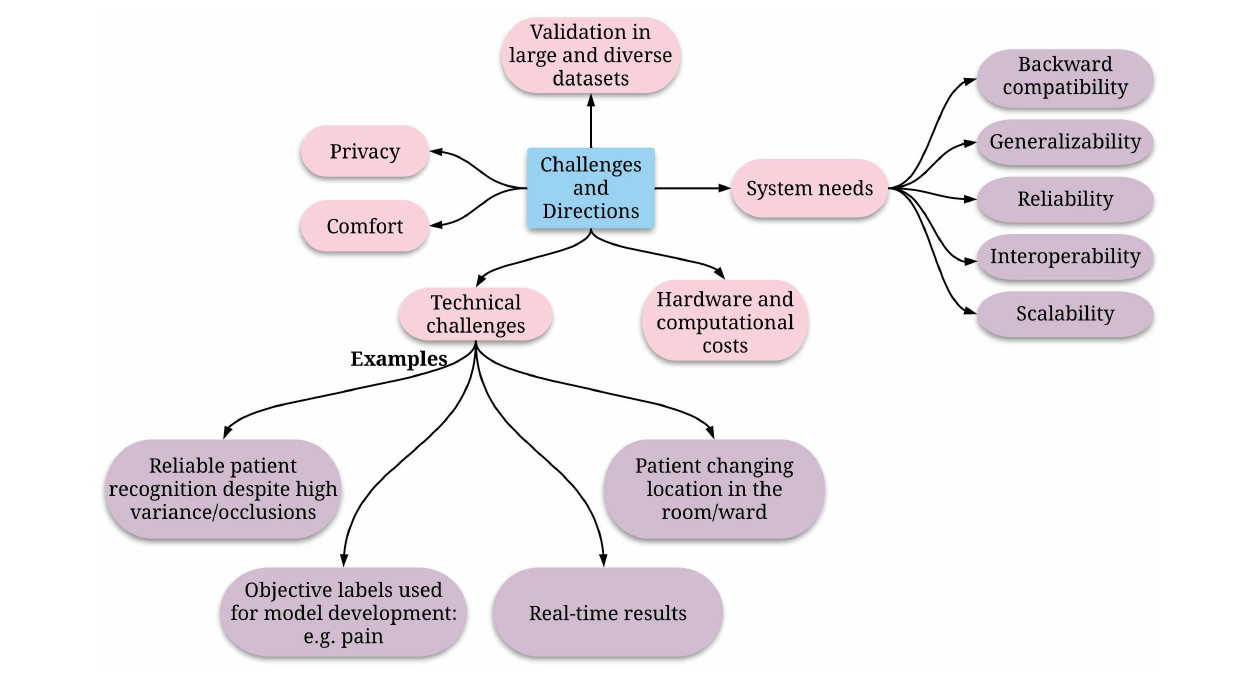
FIGURE 2 | Directions of future research to enable effective and reliable pervasive monitoring in the